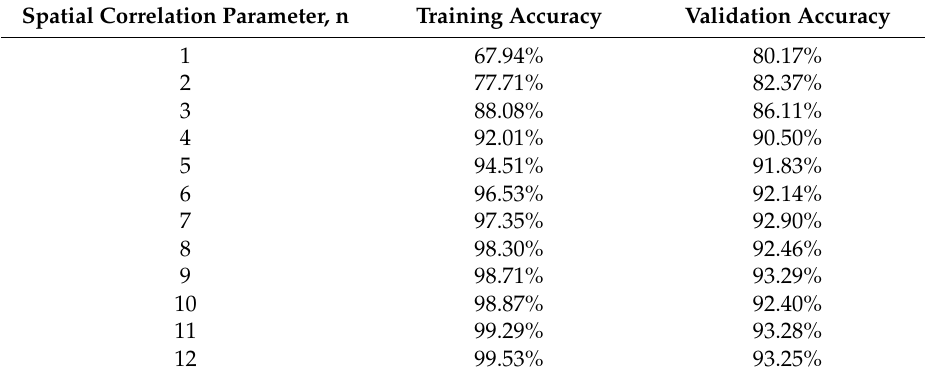
Table 1. Experimental results of the training and validation accuracy of the deep 3-D CNN model when the spatial correlation parameter, n, is assigned various values. Spatial Correlation Parameter, n